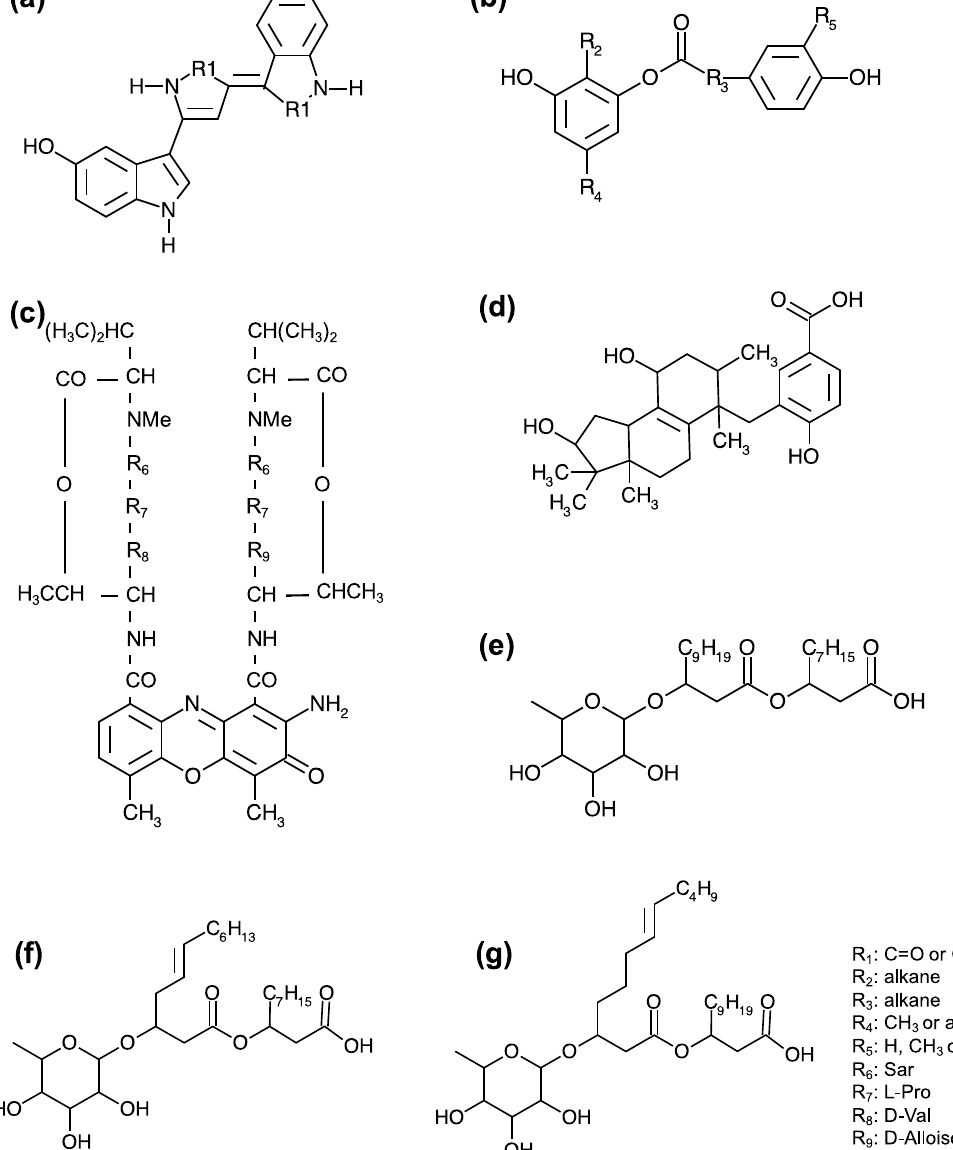
Figure 1. Chemical structures of molecules with antibiotic activity obtained from Antarctic bacteria: ( a ) Streptomyces flavovirens , ( b ) and ( c ) Flavobacterium sp., ( d ) Nostoc sp., and ( e – g ) Pseudomonas sp. All molecules, except ( e ), correspond to novel antimicrobial metabolites. Modified from: [23,54,62,72]. Three other soluble compounds from Pseudomonas sp. strain with activity against Bcc strains and S. aureus were elucidated by high-resolution electrospray ionization mass spectrometry (HRESIMS),